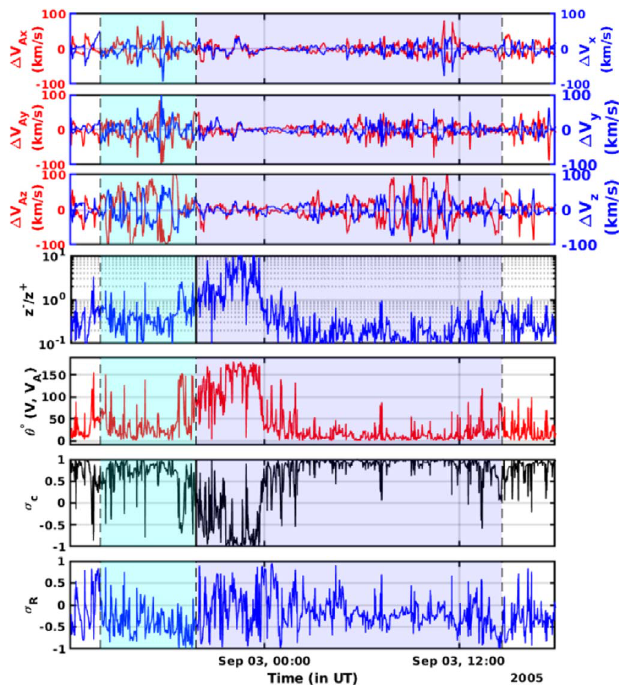
Figure 4. The top three panels show the temporal variation of fl uctuations in Alfvén velocity Δ V A i ( red ) with fl uctuations in proton fl ow velocity Δ V i ( blue ) . The ratio of Elsässer variables z − / z + is shown in the fourth panel. The presence of the angle between the magnetic fi eld and solar wind speed is shown in the fi fth panel. The last two panels represent the temporal variation of the normalized cross helicity ( σ c ) and normalized residual energy ( σ R )